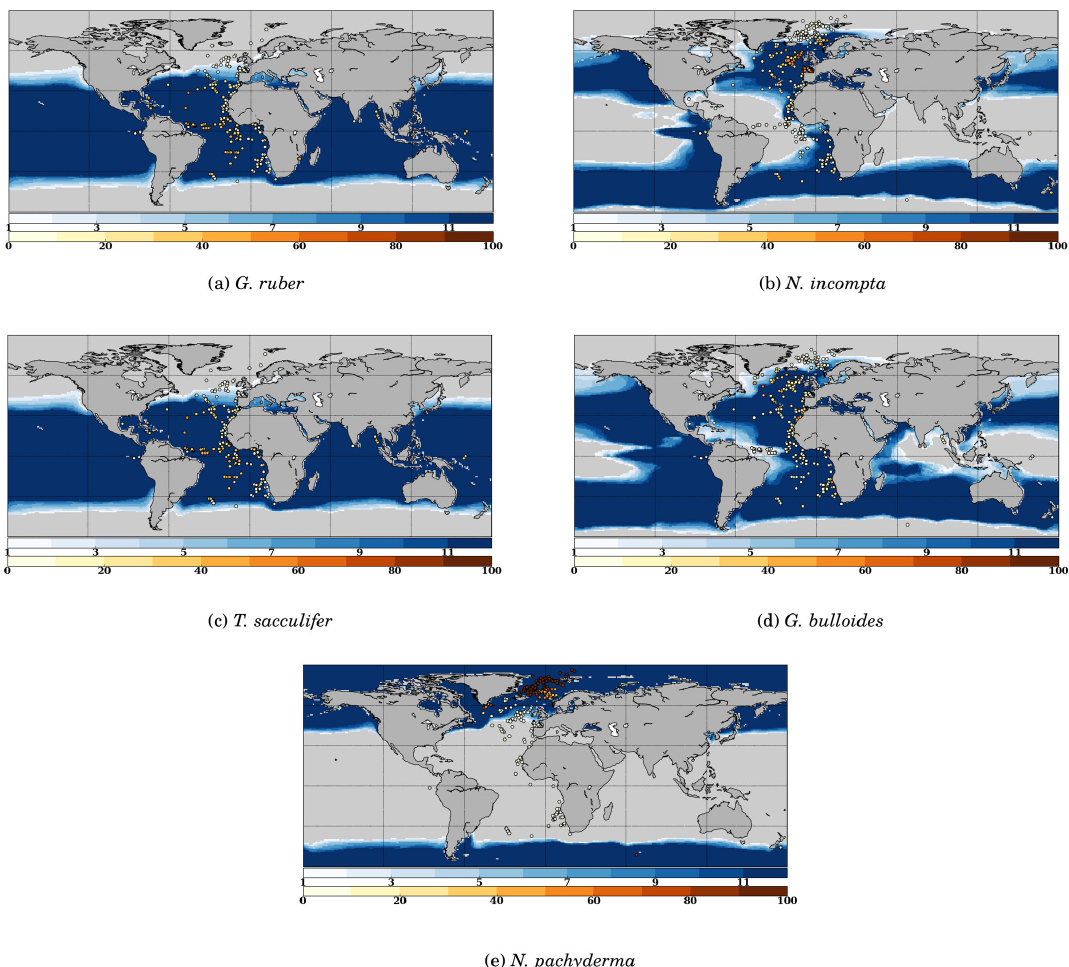
Figure 3. Model–data comparison of species’ abundances. Ocean regions where FAME predicts that the species is present at some time of the year ( µ (cid:48) > 0) are plotted in blue, with shades of blue indicating the number of months of presence. Overlaid are the MARGO Late Holocene data (quality levels 1–4) species’ abundance data, plotted using the yellow–white to dark red color bar and given in percent. A qualitative correspondence between simulated FAME presence/absence and the occurrence of 10% level in the difference species is